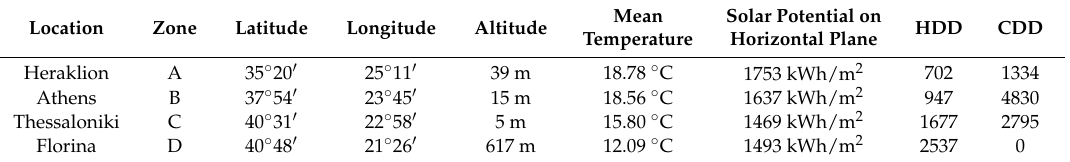
Table 1. Data about the examined climate zones. HHD—heating degree days; CCD—cooling degree days.